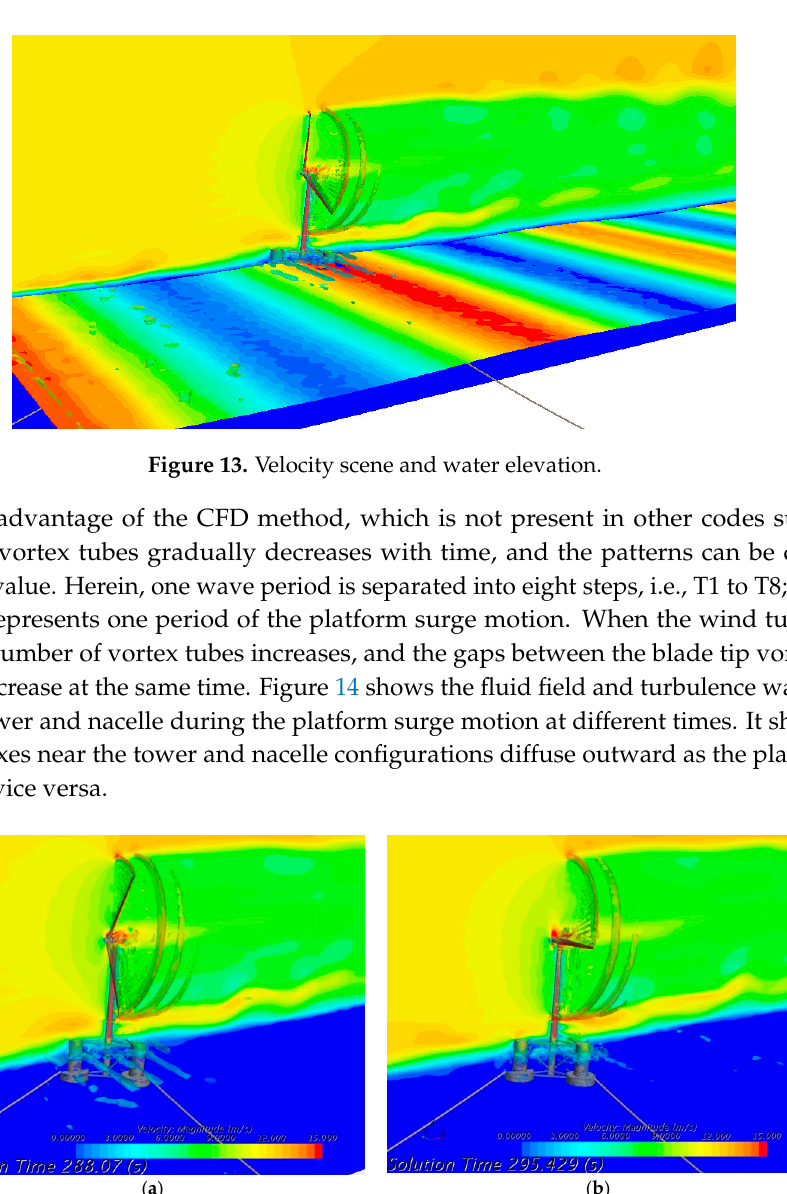
Table 7. Motion response amplitude operators (RAOs) in different environment conditions.